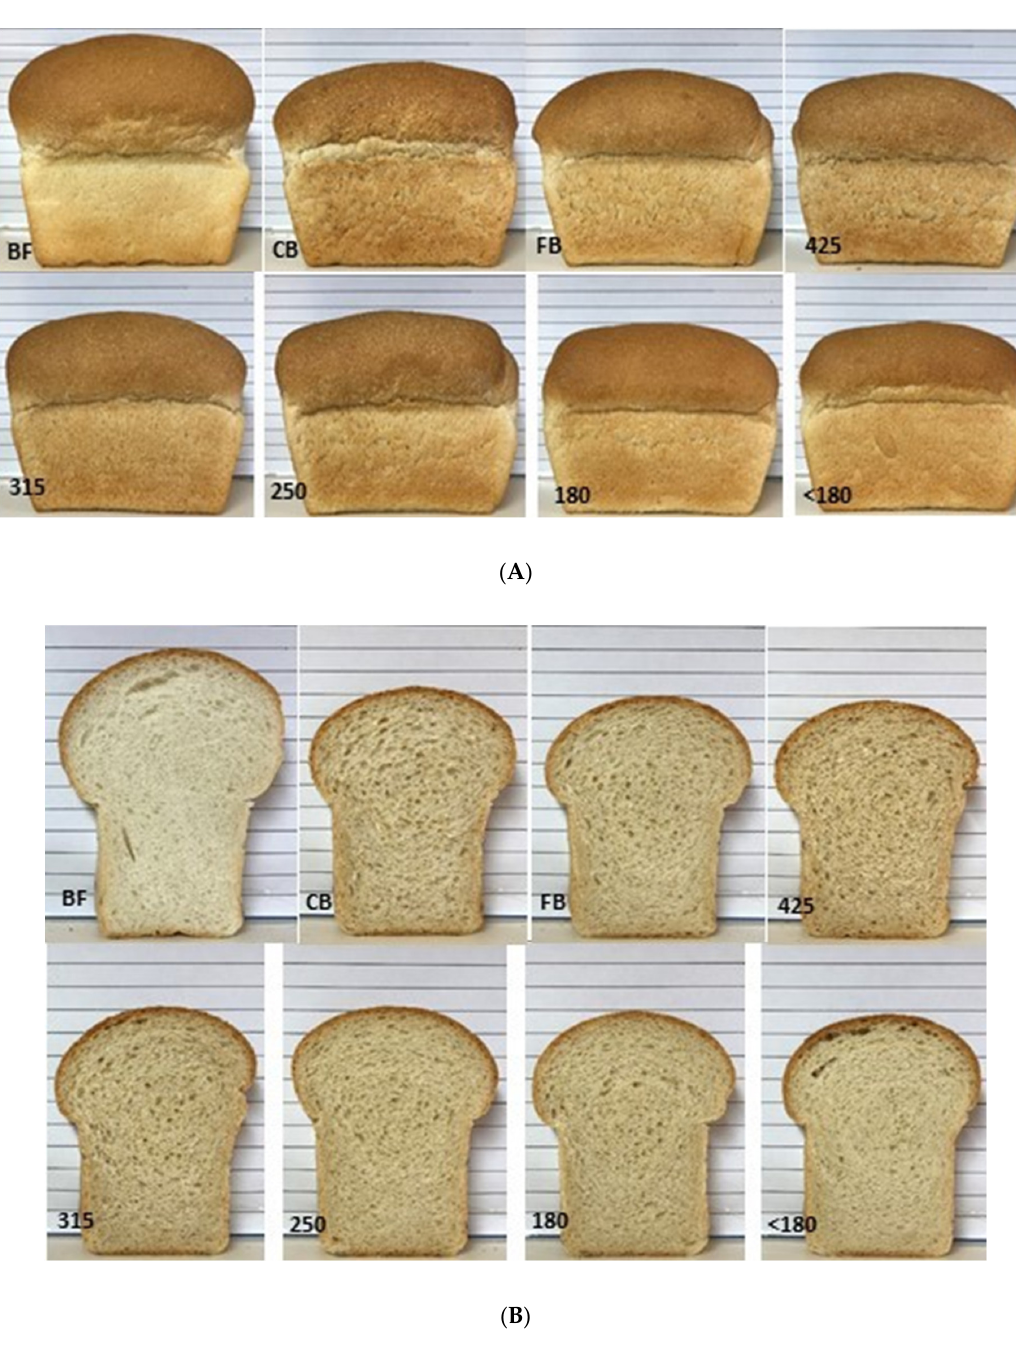
Figure 5. Loaves prepared with 100% Bakers flour (BF) and with 10% ( w / w ) bran fractions coarse bran (CB), fine bran (FB), 425, 315, 250, 180, and <180 µm. ( A ): External view; ( B ): Cross-sectional view.